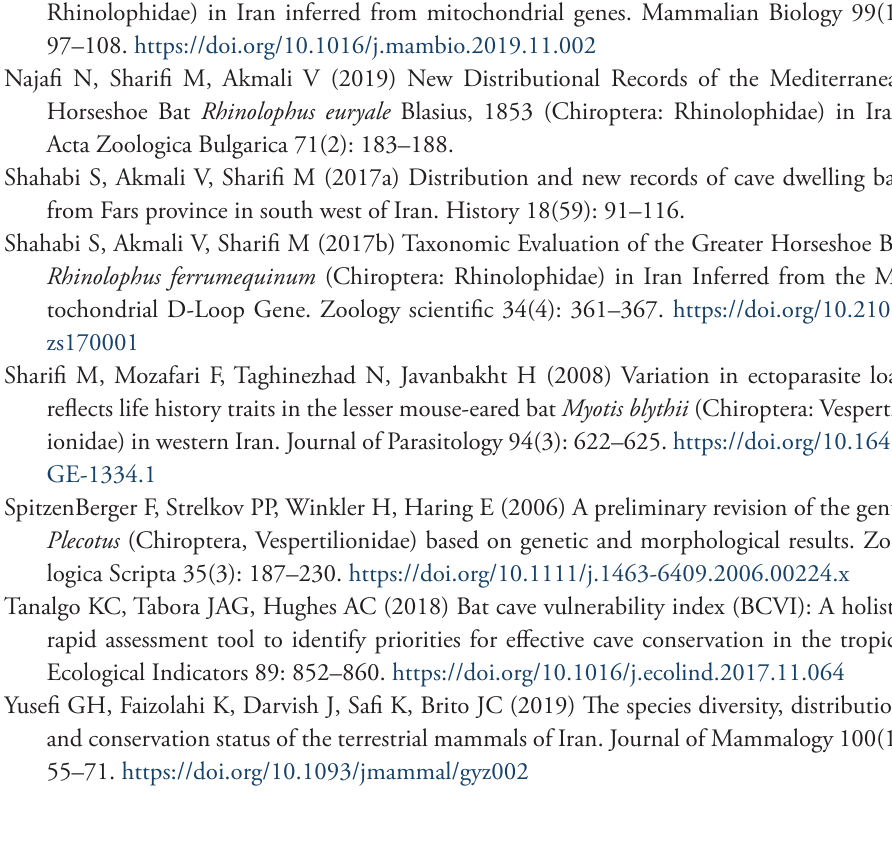
Explanation note: Figure S1. The geographical location of Kurdistan Province in the west of Iran and 28 caves investigated in the study area. Numbers refer to caves as indicated in Table 1. Figure S2. Separate distribution maps for each bat species with their site